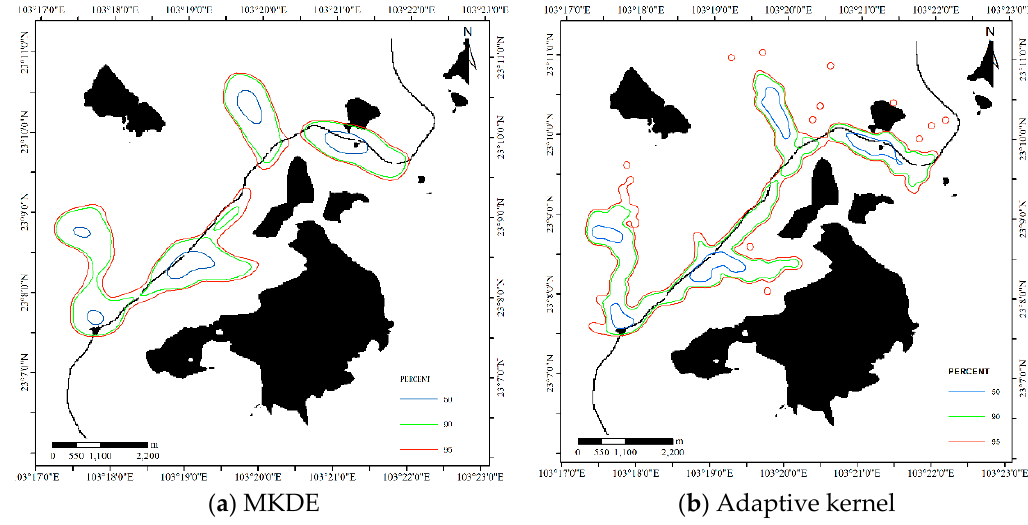
Figure 15. HR of the KDE methods for Dataset 2.